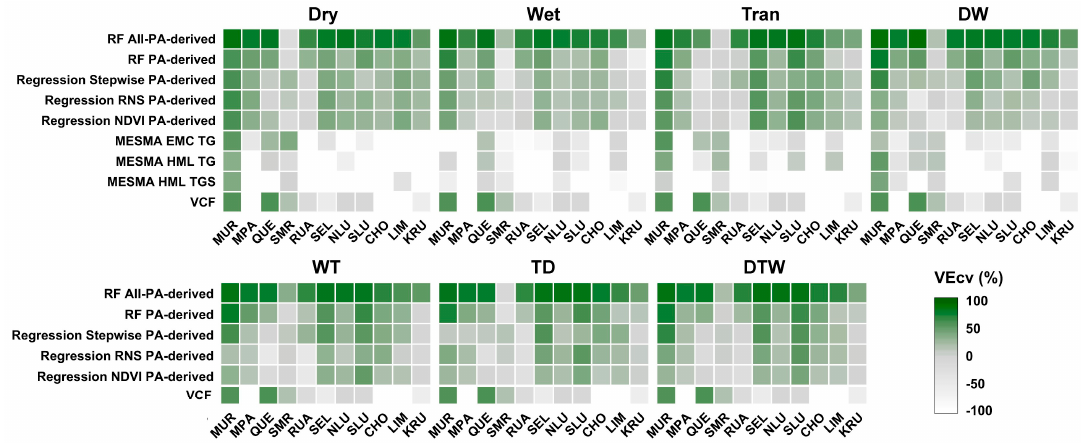
Figure 5. Heat map of model types from each approach that performed best on average across the PAs and seasons. To produce this figure, we took up to three model types from each approach (RF and VCF only had two and one, respectively) with the highest average VEcv scores across all the data. We then separated model performances by season and PA. Because the unmixing approach did not use the DTW, TD, or WT composites, those spaces are not shown. Higher scores are darker and colors with no green coloring represent accuracies below zero. The contrast between approaches is apparent, as are the lack of any clear improvement in accuracy across the images and the consistently high scores of MUR. For display purposes only, scores less than -100 were set to -100 and VCF results were repeated across